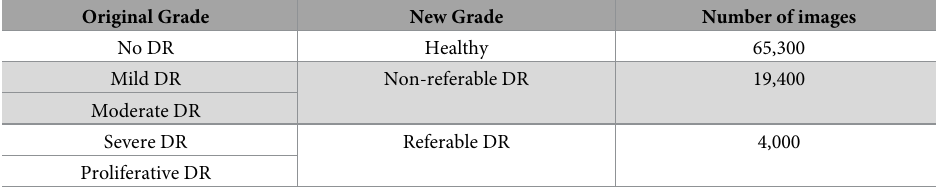
Table 1. Re-categorization of the original Kaggle EyePACS grading scheme (5 grades) to three new categories.